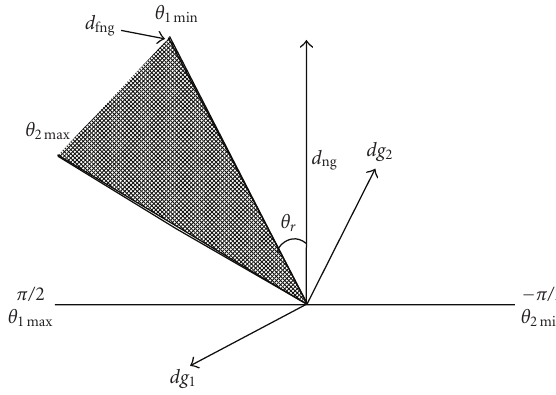
Figure 13: This figure illustrates our optimal feasible direction scheme. Note that the filled area is the resulting feasible